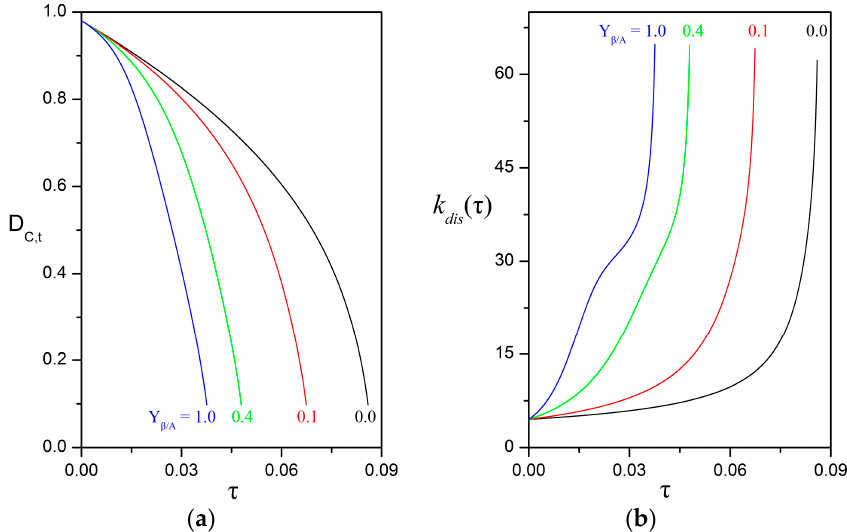
Figure 8. Impact of the biofilm yield coefficient Y β / A on the temporal evolution of: ( a ) the dimless diameter of the oily core; and ( b ) the dimless dissolution rate; for H A , υ / β = 0.1; Λ A β = 1. The other parameters are: Pe υ ,0 = 100; δ β ,0 = 0.02; h T = 6; Da υ = 0; k srn = 0; velocity mode = “const. U”.